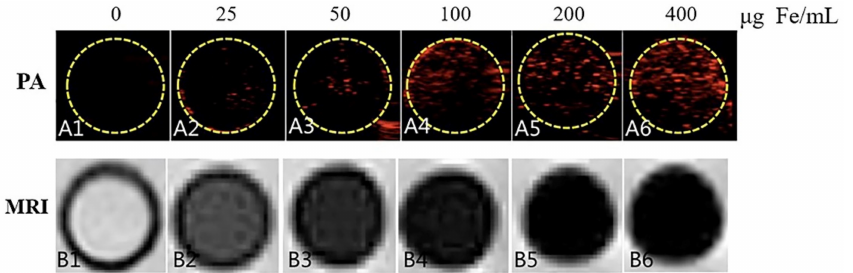
Figure 8. Dual-modal PA and MRI imaging ability of magnetic PLGA-IO MPs. Qualitative observa- tions show an enhanced PA signal with increasing iron content in the particles and a low signal on MRI [84]. Copyright 2018, Public Library of